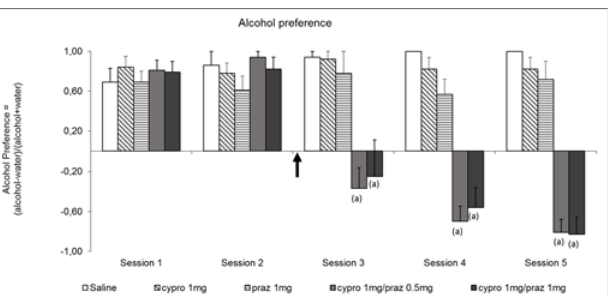
Fig 5. Effect of prazosin (praz) or cyproheptadine (cypro) separately or in combination on alcohol preference during 2 hour sessions with alcohol (10%) and water bottles. Doses of cyproheptadine and prazosin were 1 mg/kg and 0.5 mg/kg, respectively. The preference index Alcohol/Water (Pref.) is calculated as follows: Pref. = (Alcohol consumption – water consumption) / (Alcohol consumption + water consumption). All groups (N = 6 animals per group except cypro 1 + prazo 0.5, N = 9) received saline treatment at the first two sessions, cyproheptadine and prazosin treatments started at the arrow. Results are expressed as mean values ± S.E.M. Statistical analyses: repeated measures ANOVA, group effect F 4;28 = 54.8, p < 0.001, session effect F 4;112 = 18.0, p < 0.001, group × session interaction F 16;1112 = 10.0, p < 0.001; one-way ANOVAs, differences between groups in session 1 and 2, F 4;28 (cid:3) 1.3, p = ns; in sessions 3 – 5 F 4;28 (cid:1) 9.5, p < 0.001; post-hoc comparisons, Dunnett test, (a) significantly different ( p < 0.05) from saline group.